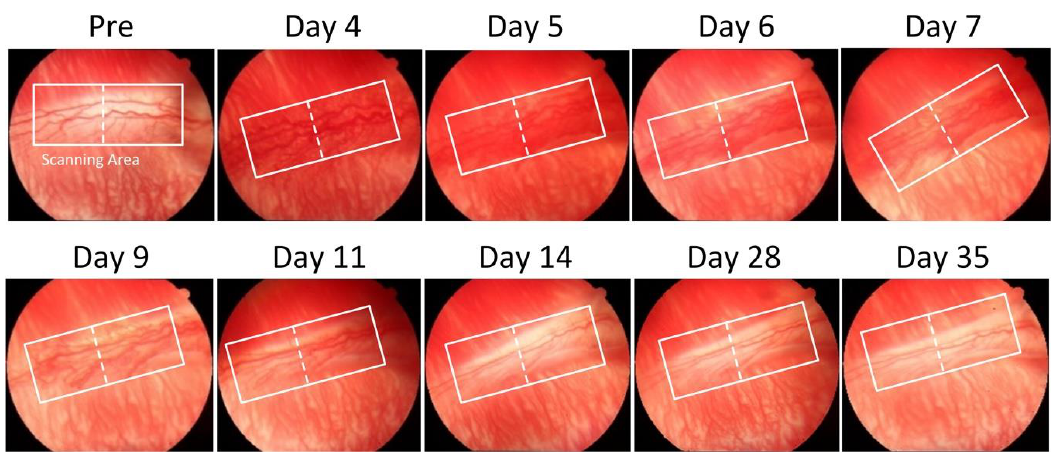
Figure A1. Color fundus photography of the retina before and after dual PAM and OCT experiment. As shown in this figure, the morphology of retinal vessels and retina is normal, indicating that the application of laser light at 80 nJ does not result in visible retinal damage.